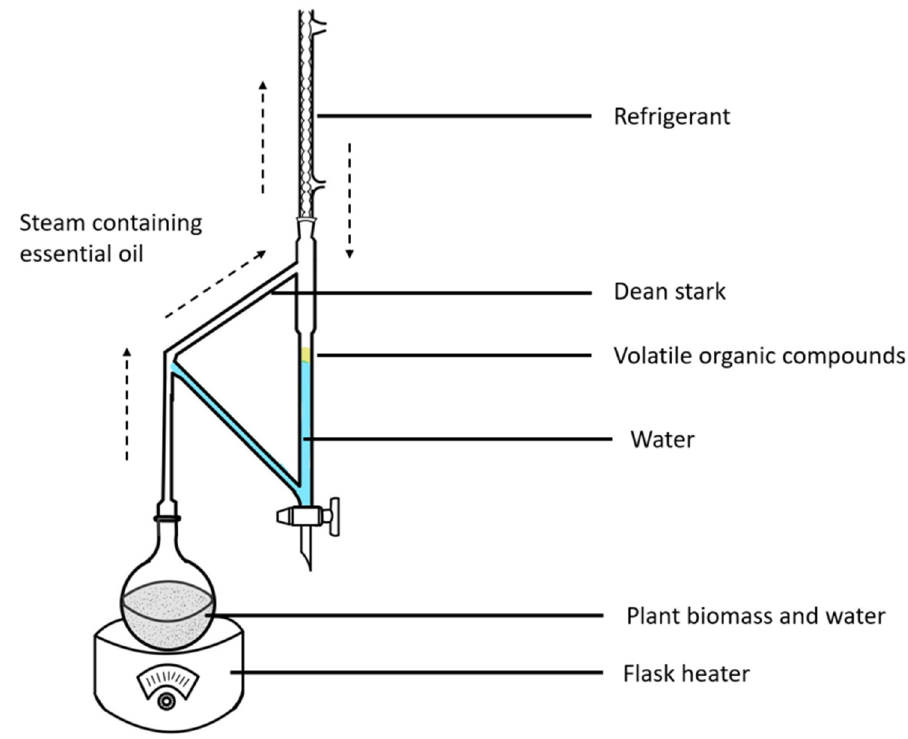
Figure 1. The Clevenger apparatus is a tool used for essential oil extraction using steam. This technique uses temperature to separate the volatile compounds from the plant biomass, and the organic compounds are separated using steam so as not to degrade the VOCs. The Clevenger-type apparatus conducts the distillation process by boiling, condensing, and decantation to separate the oil. This is the official standard method for extracting essential oils for quality control.